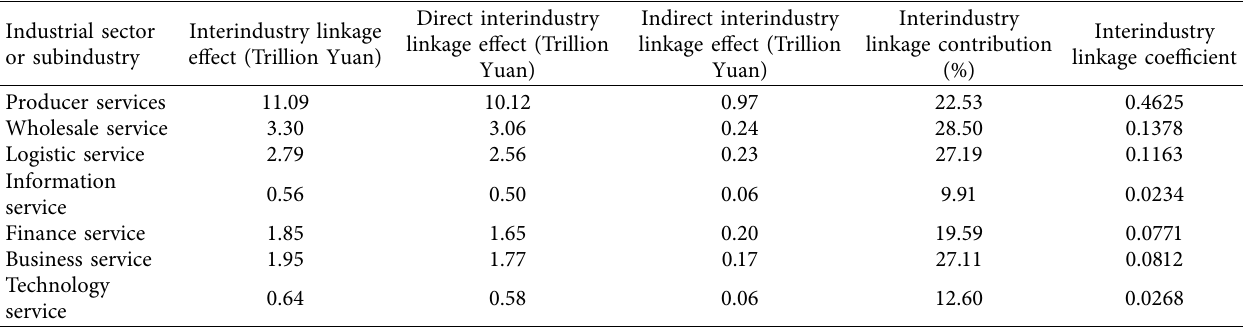
Table 5: Interindustry linkages from manufacturing to producer services and its